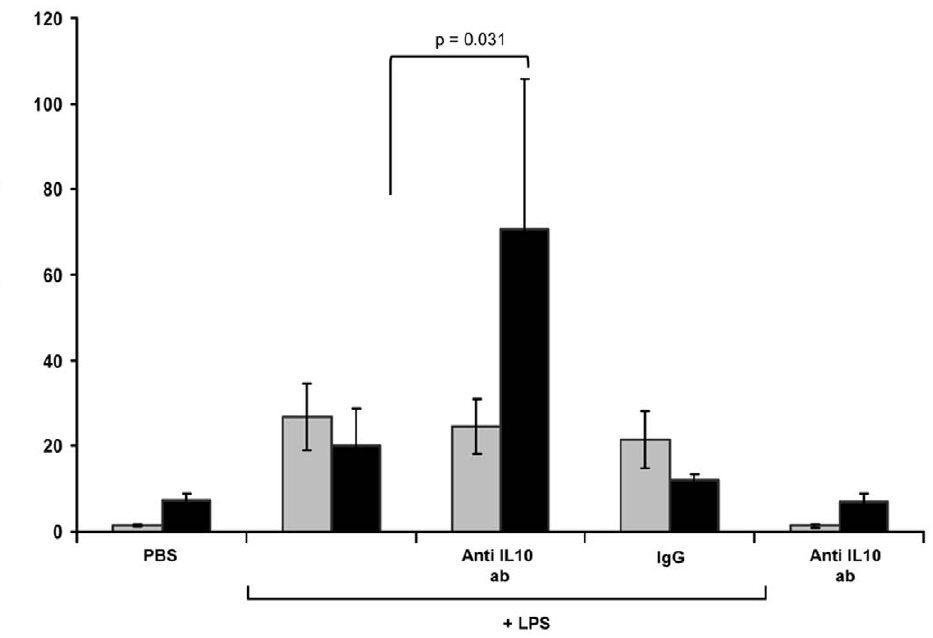
Figure 2. Fold changes in gene expression of IL-10 in monocytes measured by RT-qPCR. Monocytes from the newly born were preincubated with anti-IL-10 antibody for 1 hr followed by endotoxin (LPS) stimulation for 4 h (gray bars) and 18 h (black bars). PBS alone, anti-IL-10 antibody without LPS stimulation and IgG with LPS served as controls. Values are mean 6 SE (n=6).